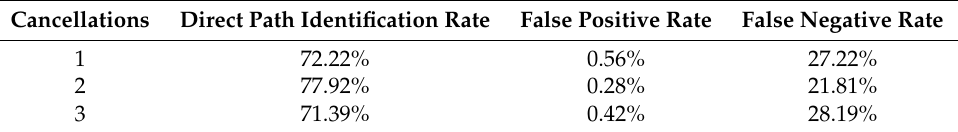
Table 6. Direct path identification rate of NC-MUSIC in UMa scenario.